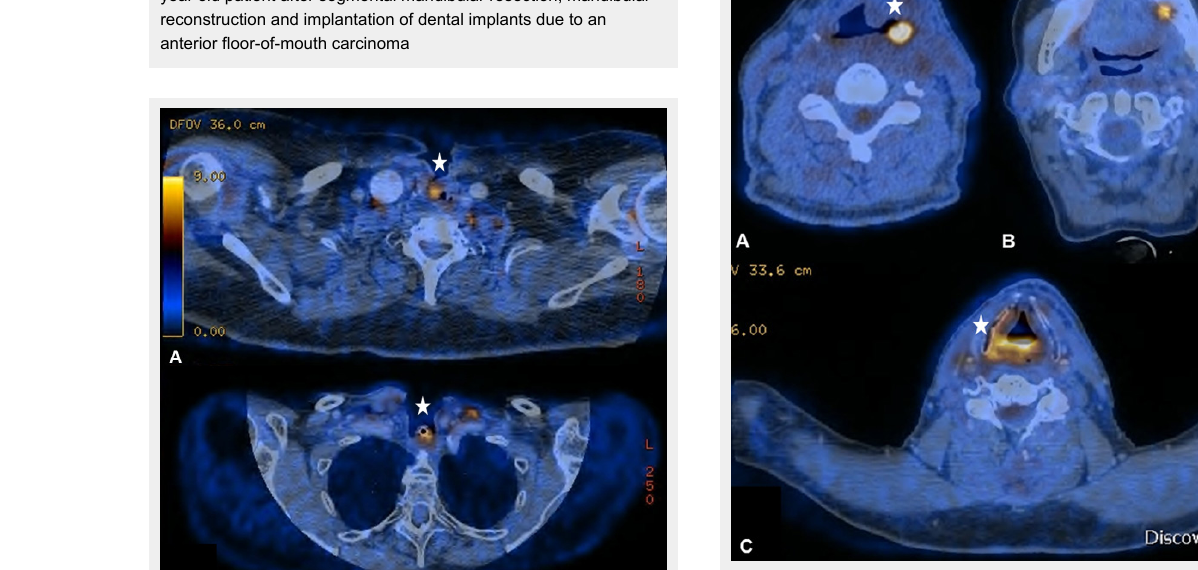
(A) Increased focal uptake in the right submandibular gland in a 54-year old patient, who underwent surgical resection and reconstruction with a pedicled flap owing to a lateral tongue carcinoma. (B) The corresponding T1–weighted magnetic resonance imaging helps to delineate the shifted submandibular gland due to the pectoralis maior myocutaneous flap. (C) Sixty-six